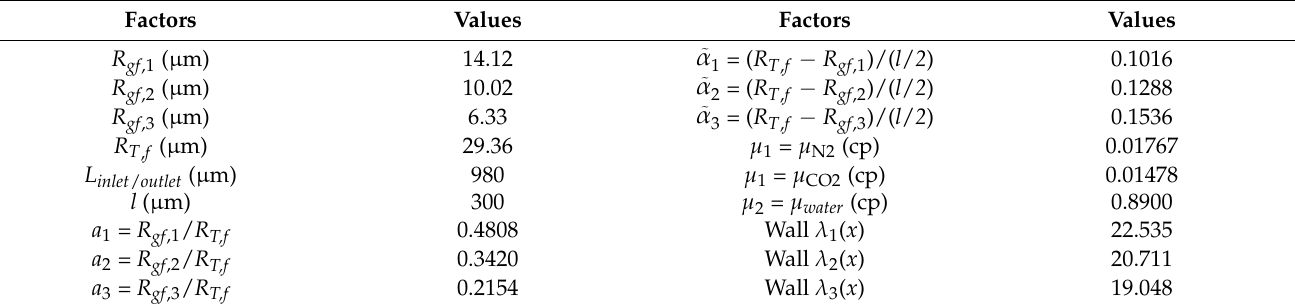
Figure 2. Model Specifications Illustration: ( a ) Experiment Glass Chip Structure, ( b ) Axisymmetric Table 1. Calculated Factor for the Micromodel. Pore Throat, ( c ) Continuously Tapering Pore Throat . Table 1. Calculated Factor for the Micromodel. In Figure 2, R T represents the pore body radius, R T , f represents the converted pore body radius with a circular cross-area, R g represents the pore throat radius with a rectangular cross-area, and R g , f represents the converted pore throat radius with a circular cross-area. According to the hypotheses of Beresnev and Deng and Quevedo Tiznado et al. [9,11], a two- Table 1. Calculated Factor for the Micromodel. dimensional coordinate system is developed based on the pore throat area of microchips, Table 1. Calculated Factor for the Micromodel. and it stretches out in a 980 µ m straight channel horizontally along the fluid flow direction Table 1. Calculated Factor for the Micromodel. from both intake and outlet. The numerical model is based on the same microchip shape as seen in Figure 2. The correlated factors are calculated from the experiment glass model, and the results are shown in Table 1, where λ ( x ) represents the radial coordinate of the capillary wall. Equation (1) shows the calculation process for λ ( x ) [9]. In both Equation (1) and Table 1, l represents the length of the defined channel, a is the ratio between the radius of the pore throat and the pore body, ᾶ represents the ratio between the radius of the pore body and half of the defined channel, and μ represents the viscosity of the fluid. Table 1. Calculated Factor for the Table 1. Calculated Factor for the Micromodel.